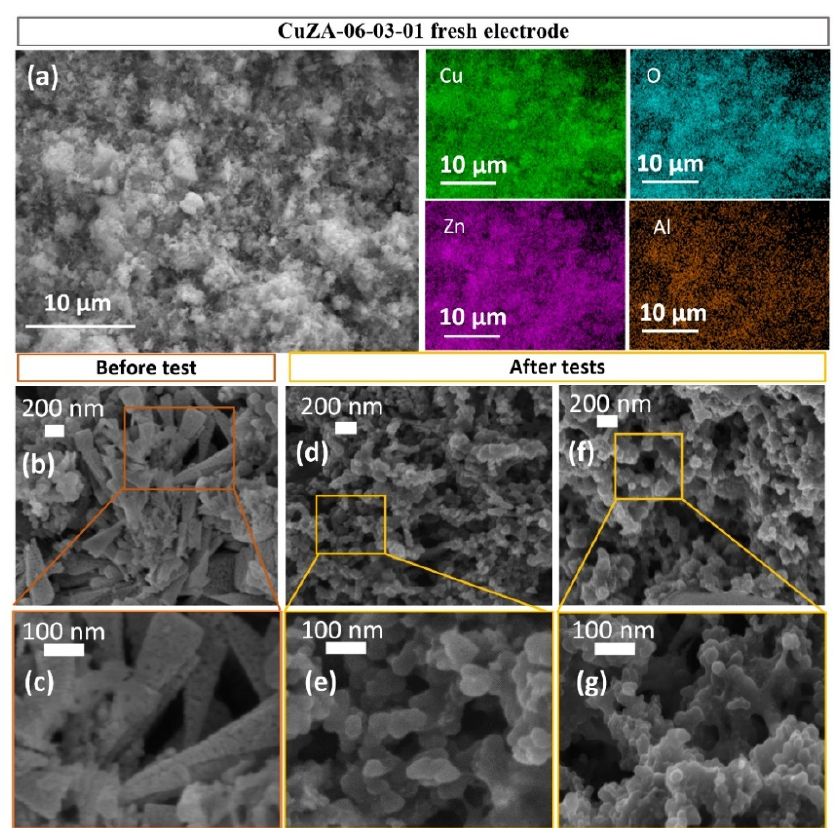
Figure 9. FESEM-EDS analyses of CuZA-06-03-01 GDEs: ( a ) Low magnification FESEM image and EDS maps of Cu, O, Zn, and Al elements on the fresh electrode; FESEM images before ( b , c ) and after ( d – g ) electrochemical CO 2 reduction tests in the 0.1 M KHCO 3 electrolyte at − 12 mA cm − 2 ( d , e ) and − 24 mA cm − 2 ( f , g ).